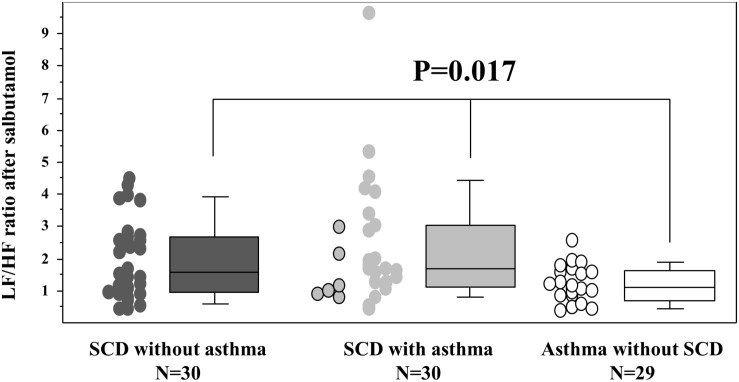
Response to salbutamol stimulation. Sympathetic stimulation was obtained after 400 μg of salbutamol administration (10 min after inhalation). The six SCD patients with typical asthma are individualized in the SCD asthma group as circles on the left side of the group with the black contour line. The p value is that of the Kruskal–Wallis test between the three groups. The Mann–Whitney U tests further demonstrated that the two SCD groups differed from the asthmatic non-SCD group (data not shown). The box and whisker plots show median, 25 and 75th percentiles, and 10 and 90th percentiles.